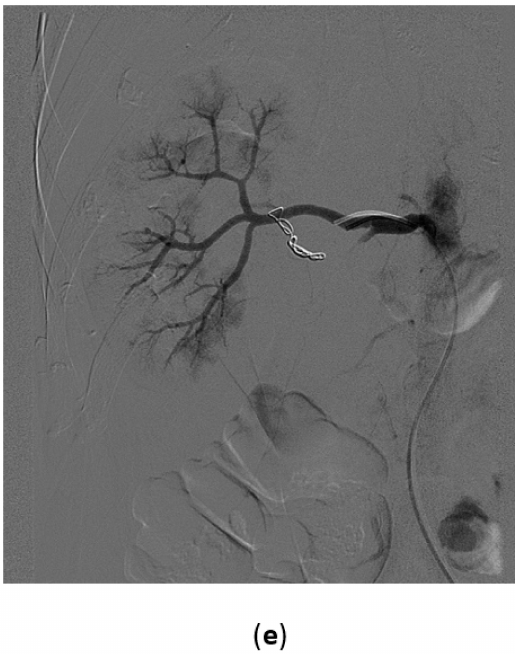
Figure 5. Angiomyolipoma. 54-year-old female with sudden onset of right flank pain. ( a ) Unen- hanced CT: the right kidney is dislodged anteriorly by a perirenal hematoma with a mixed pattern consisting of fat attenuation density and high attenuation density due to acute bleeding; ( b , c ) Con- trast enhanced CT: AML shows a “jet” sign due to active extravasation inside the mass; ( d ) Selective angiogram of the feeding artery confirms the typical aspects of AML: rich vascularization with aneurysmatic aspects; ( e ) Complete devascularization of the AML after embolization with particles and